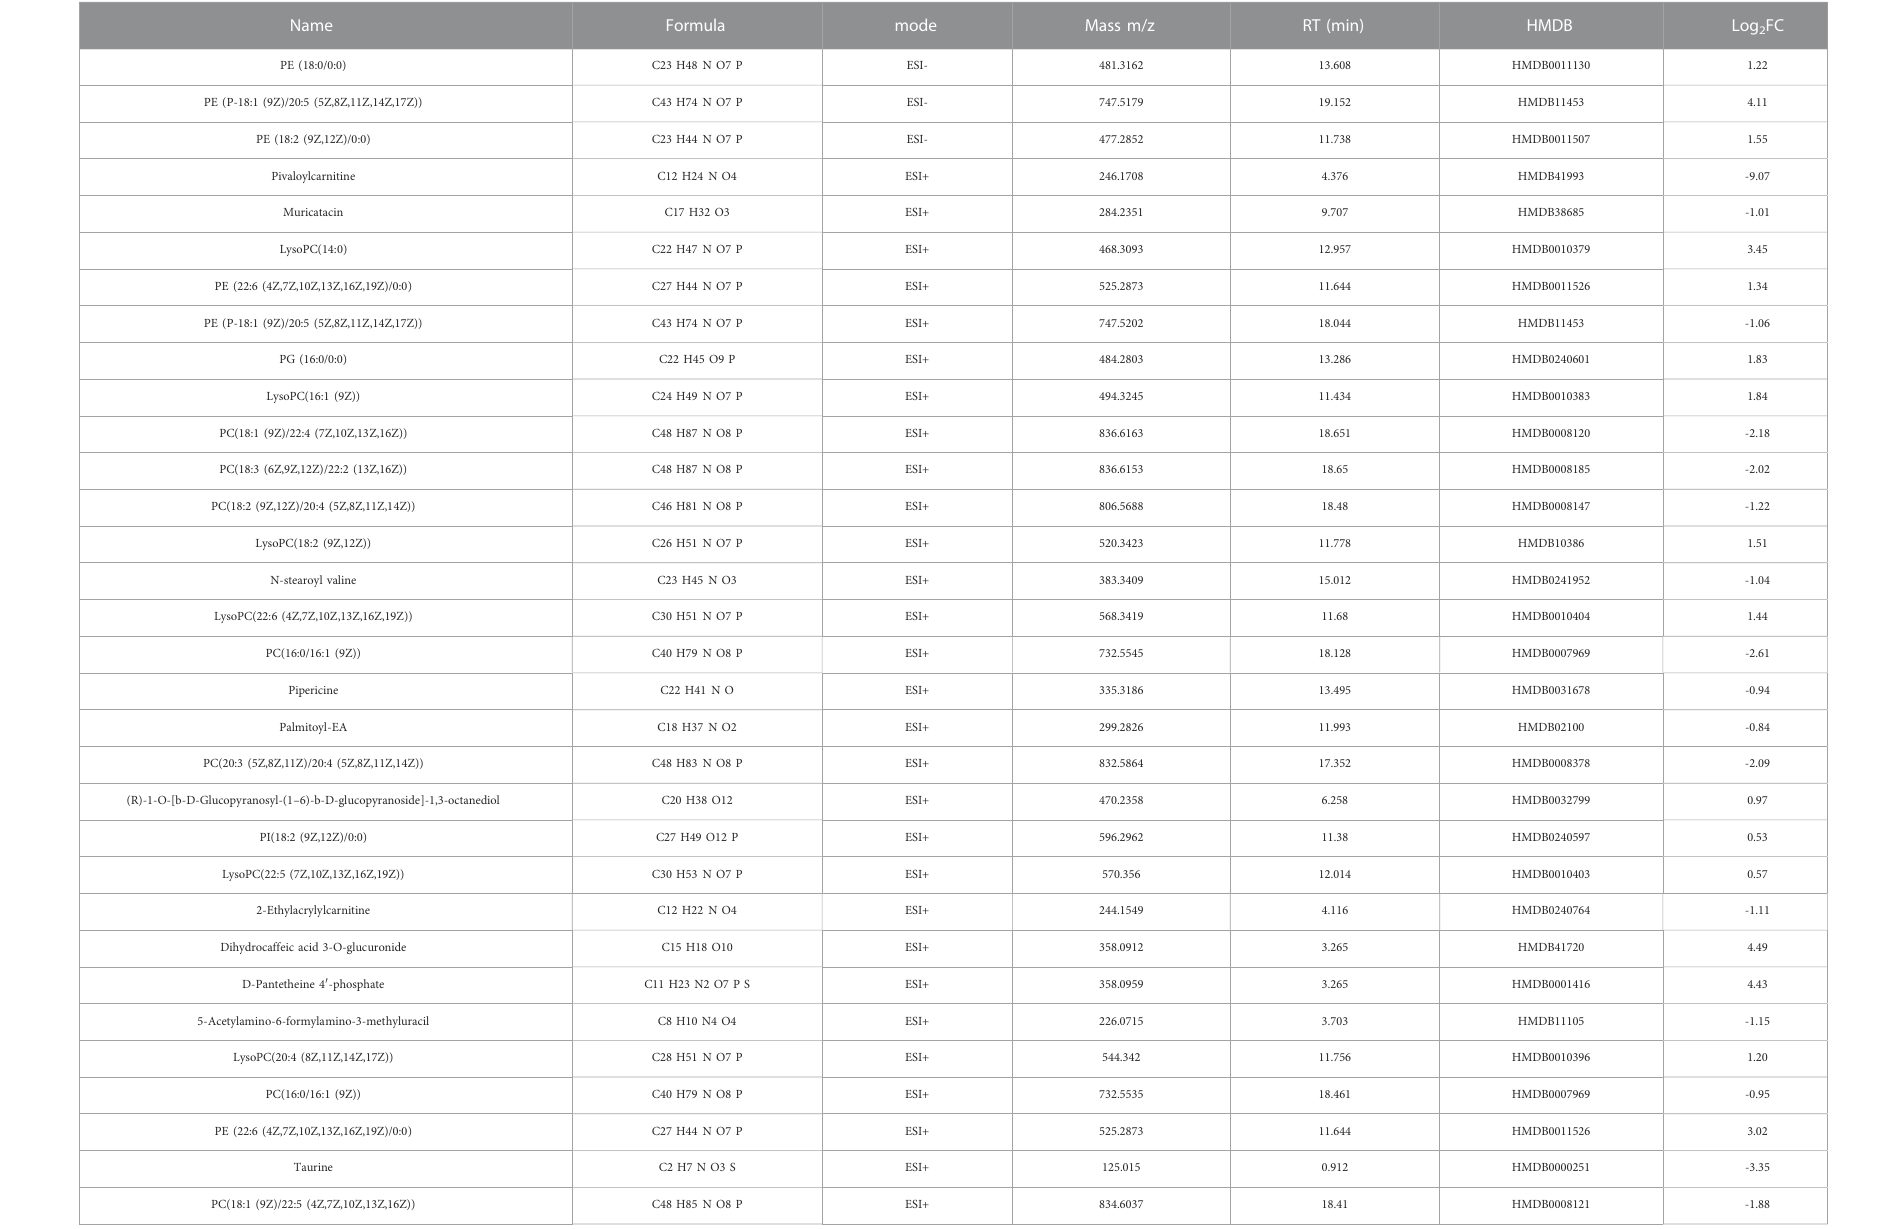
TABLE 6 Differential metabolites of QWQX I anti-chronic heart failure-related rat cardiac tissue ( p < 0.05). Name Formula mode Mass m/z